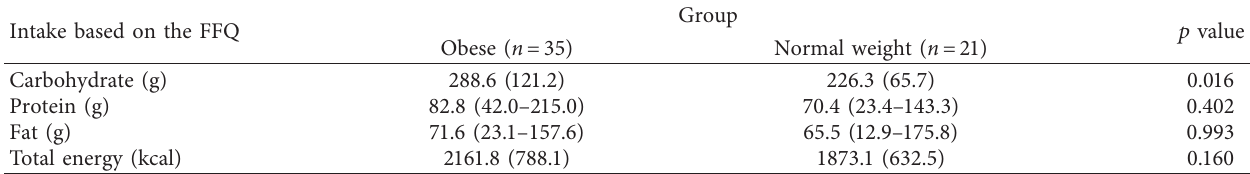
Table 4: Comparison of nutritional intake based on the FFQ between obese and normal-weight individuals.